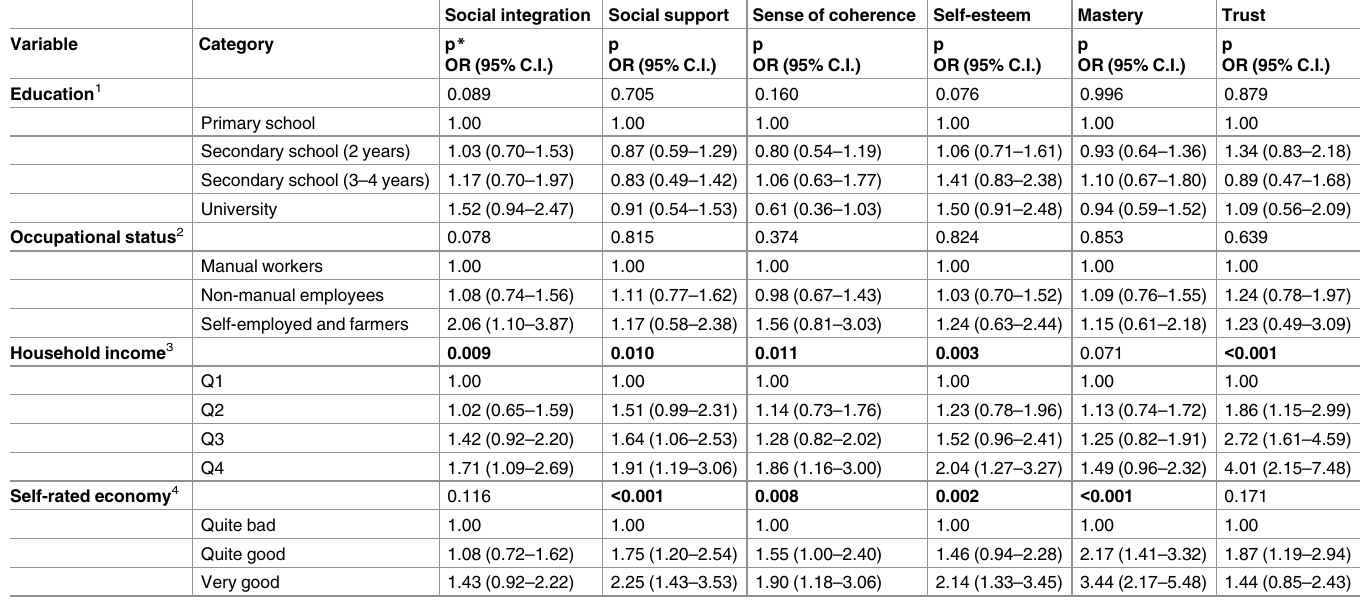
Table 6. Logistic regression models of socioeconomic status and psychosocial resources, adjusted for age, sex, country of birth, employment status and other measuresof SES. Social integration Social support Sense of coherence